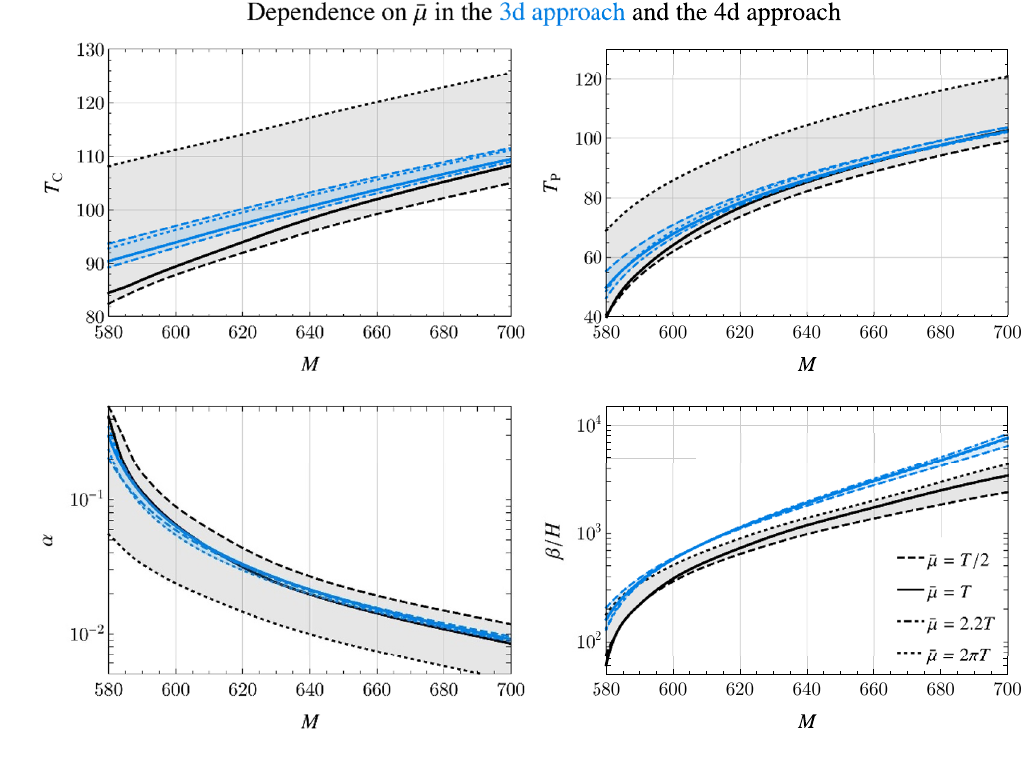
Figure 2 . A comparison of the dependence on the renormalisation scale, ¯ µ , in the daisy-resummed (black) and dimensionally-reduced (blue) approaches. The thermodynamic quantities are calculated for different choices of ¯ µ , with uncertainty bands indicating the envelope spanned by these